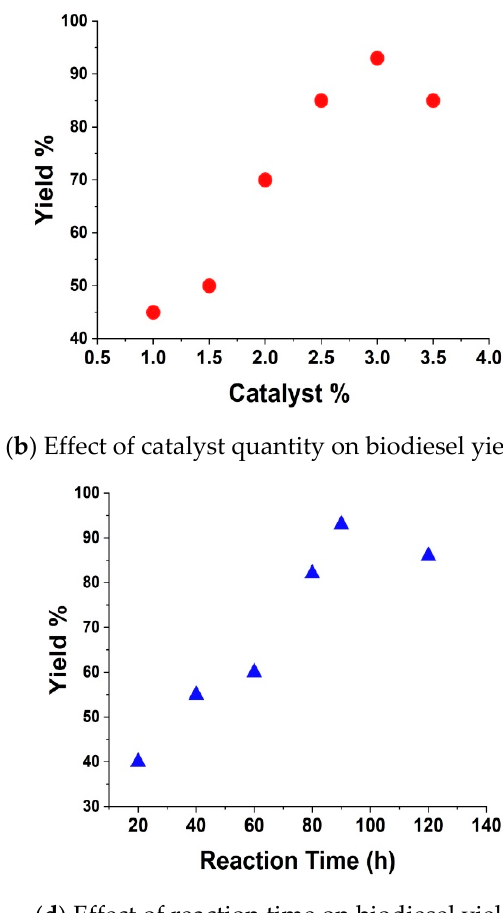
Figure 8. Optimization of parameters for transesterification process.